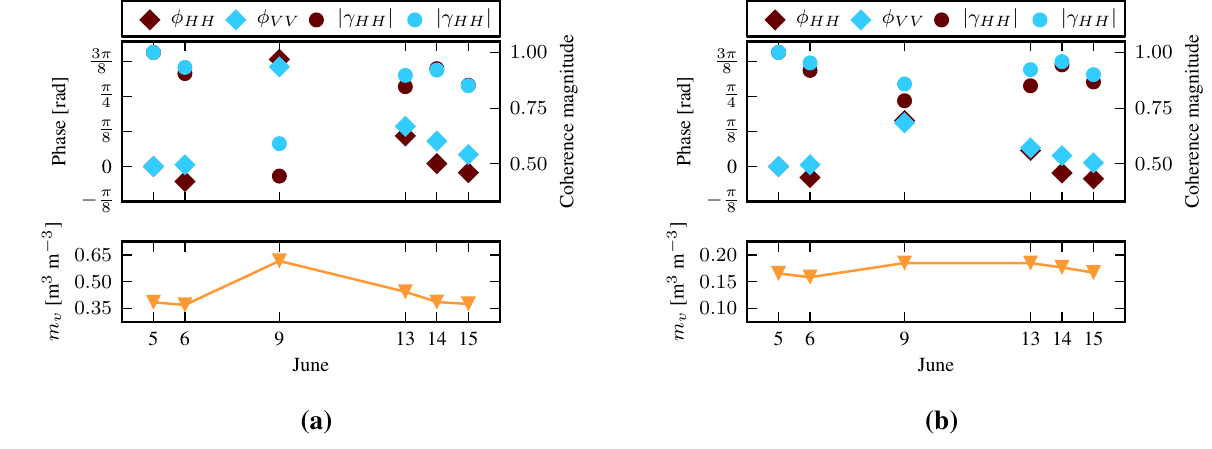
Figure 4. Time series of measured phases φ and absolute coherences | γ | in two fields, where the master acquisition m is 5 June. The soil moisture values m respective field are shown in the second panel; their dynamic ranges differ by about one order of magnitude. ( a ) ROI 307a; ( b ) ROI